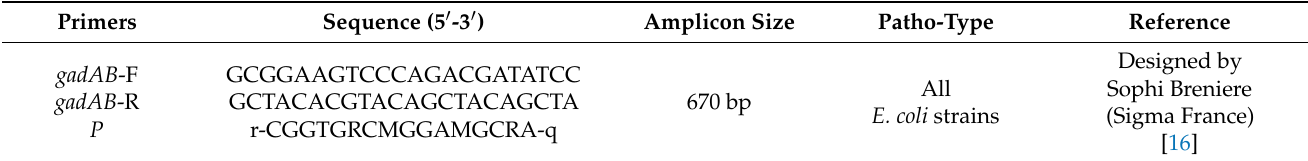
Table 1. Primers and probe used in the q-PCR